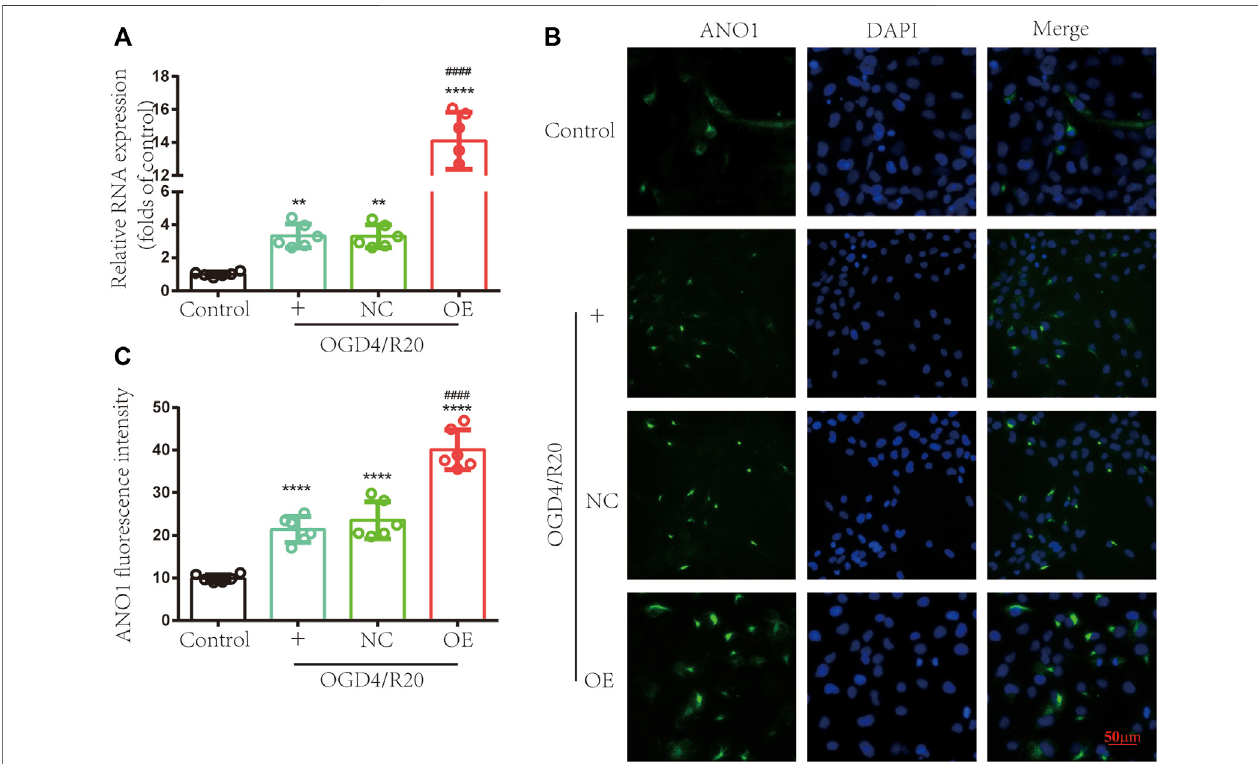
FIGURE 7 | Upregulating lncRNA ENST00000530525 increased the expression of ANO1. The effects of lncRNA ENST00000530525 upregulation by plasmid on the geneand protein expression ofANO1 inhCMEC/D3cells after OGD4/R20 conditions. (A) The RT – qPCRresults show thatANO1 increasedafter OGD4/R20,which increasedmoresigni fi cantlywhenlncRNAENST00000530525wasupregulatedbytheplasmid. (B,C) Theimmuno fl uorescenceresultsshowthattransfectingaplasmid intohCMEC/D3cellsresultedinanincreaseinANO1proteinexpression.Scalebar:50 μ m.NC:negativecontrol;OE:overexpression;OGD4/R20:4 hofOGDand 20 h of reoxygenation. ** p < 0.01, **** p < 0.0001 (vs. Control); #### p < 0.0001 (vs. NC), n = 6, one-way ANOVA.